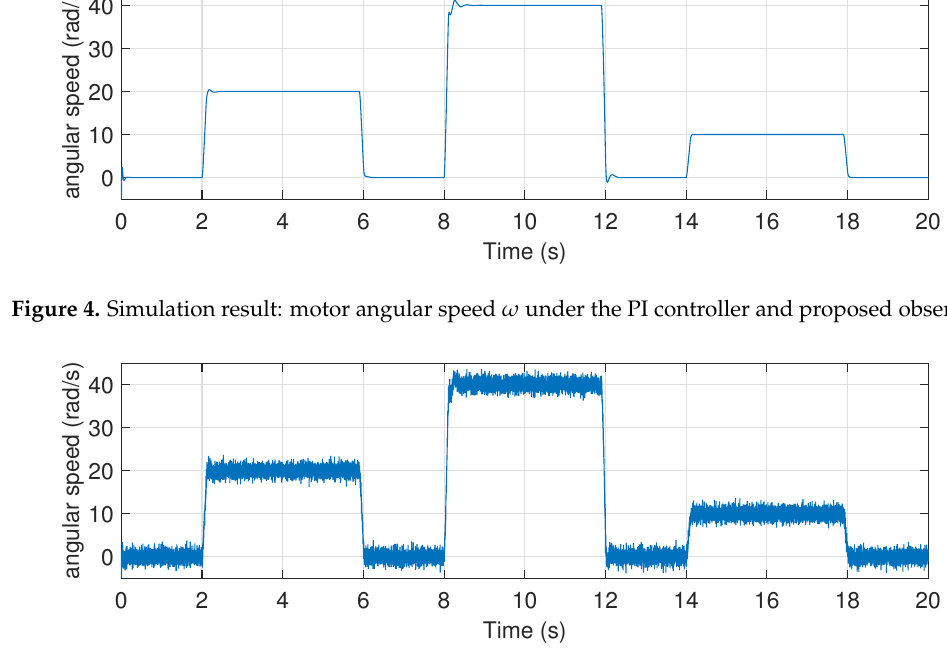
Figure 5. Simulation result: motor angular speed ω under measurement noise.